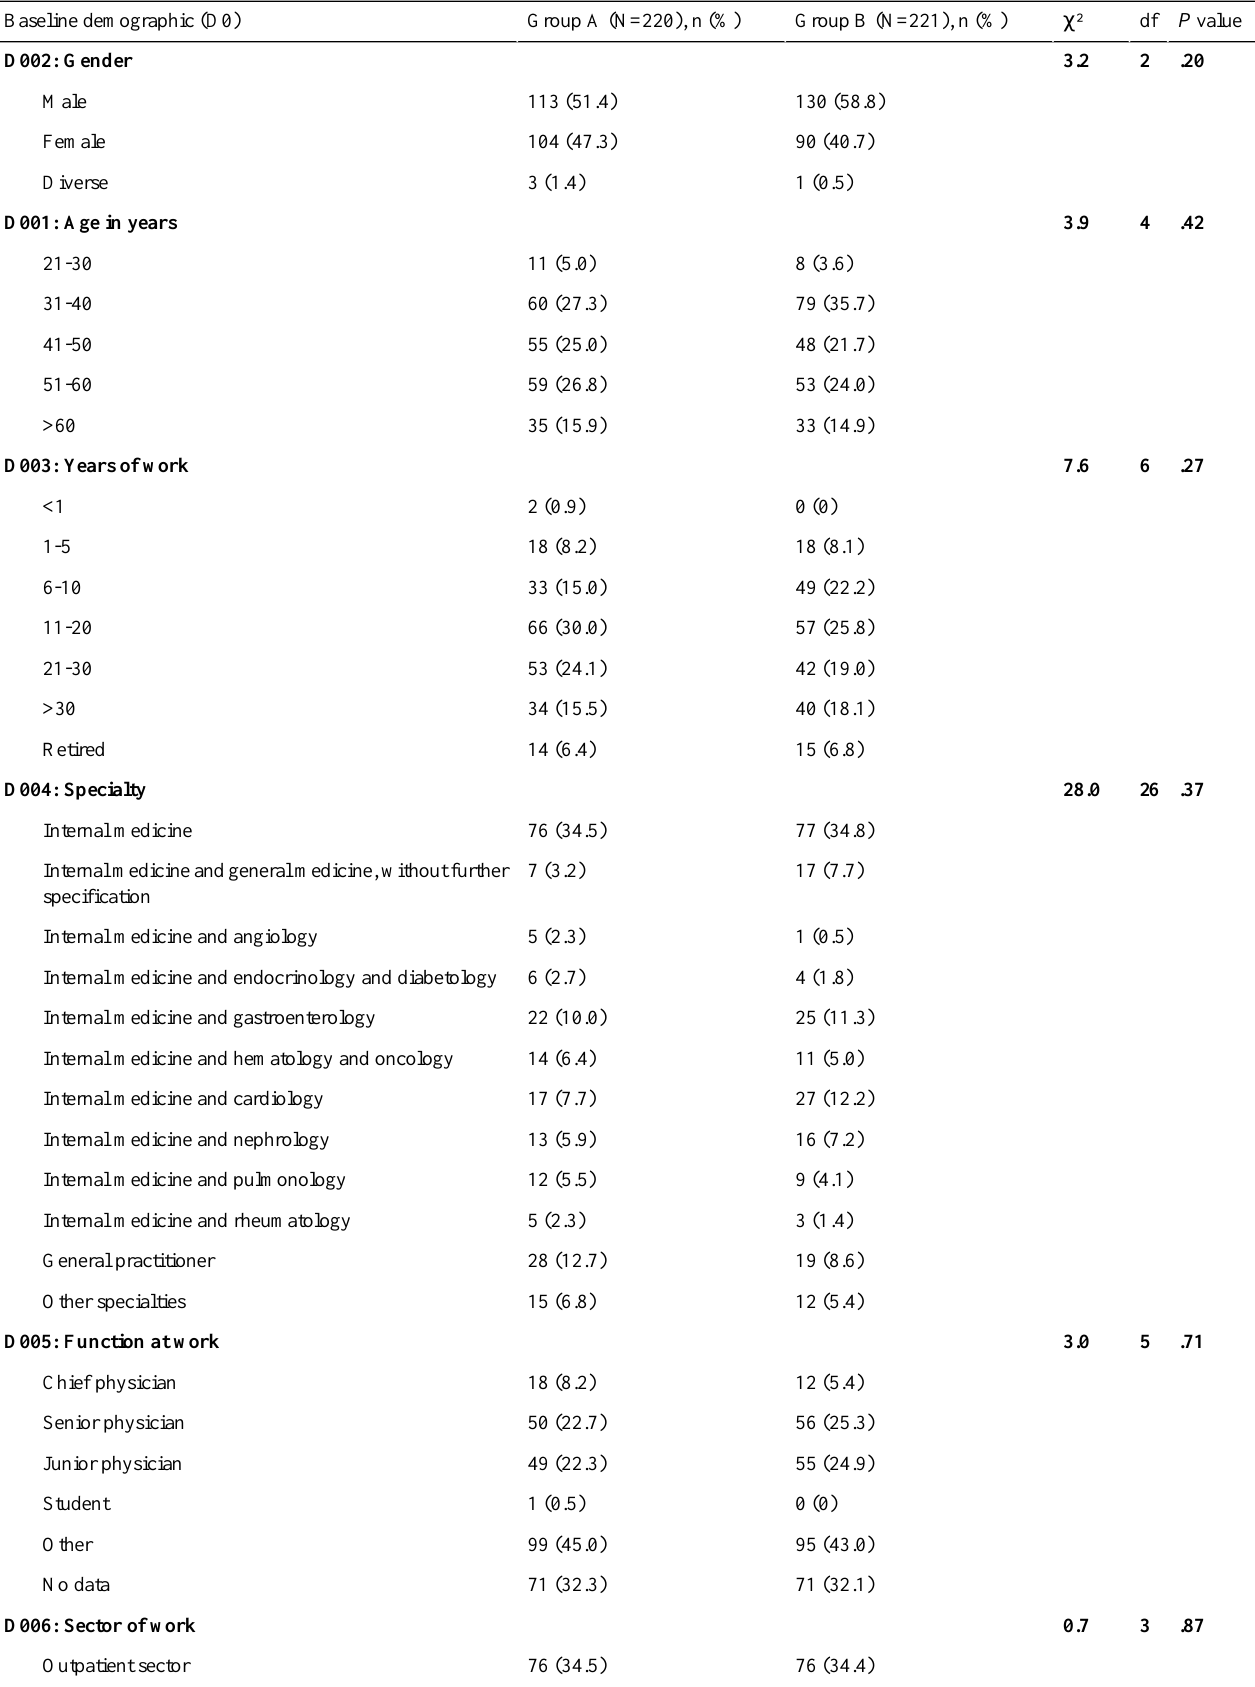
Table 6. Baseline demographics of all participants who completed the questionnaire; demographics are stratified by gender for the randomly assigned groups A and